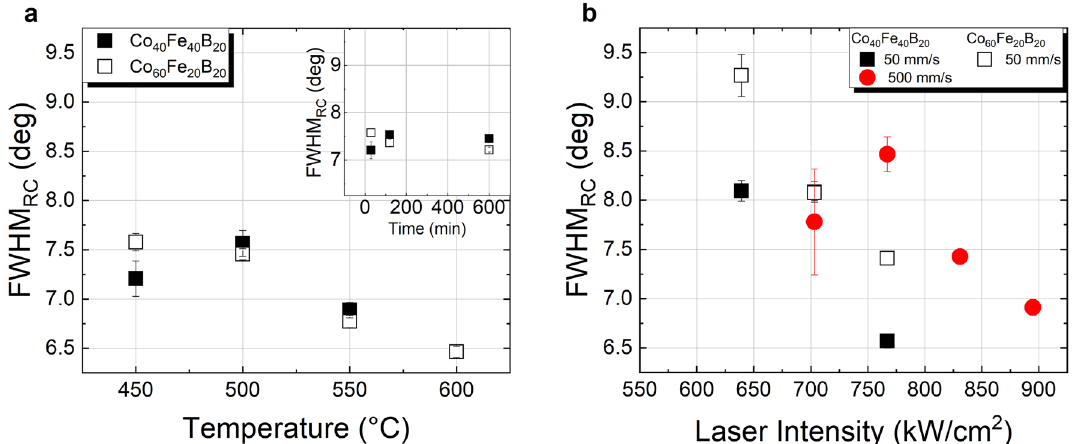
Figure 3. Comparison of the rocking curve FWHM for both Co–Fe compositions with a Ta capping layer annealed: ( a ) in furnace for 30 min at temperatures in the range of 450 °C–600 °C and at 450 °C at different times (inset); ( b ) by cw laser irradiation with different scanning speeds and different laser intensities (please note the overlap of data points for Co 40 Fe 40 B 20 (filled squares) and Co 60 Fe 20 B 20 (empty squares) at 700 kW/cm 2 laser intensity, 50 mm/s scanning